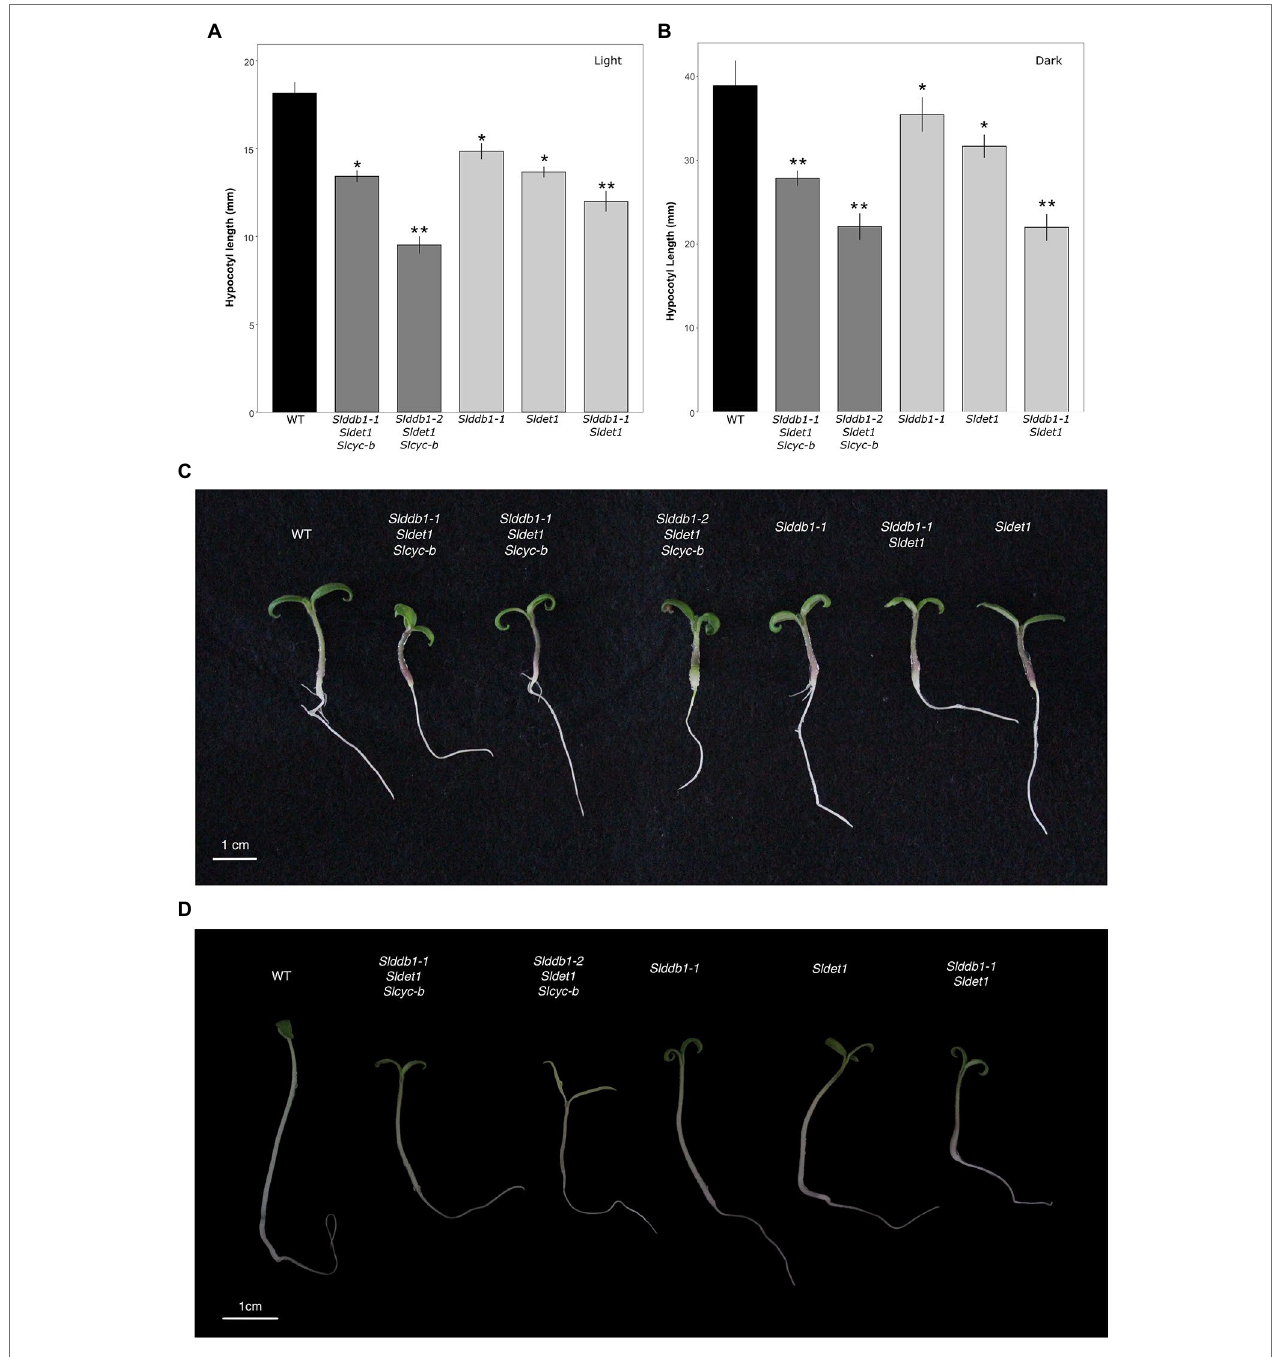
FIGURE 3 | Photomorphogenesis in segregating T 3 and BC 1 F 3 generations. Seedling development of 7-day-old germinated seeds in the T 3 and BC 1 F 3 generations under light or dark conditions, as indicated. (A,B) Hypocotyl length measurements in the T 3 and BC 1 F 3 generations under light and dark conditions, respectively. Black indicates WT, dark gray indicates T 3 triple mutant lines, and light gray indicates BC 1 F 3 segregants. (C) Photography of 1 week-old germinated plantlet under light condition. White bar indicates 1 cm. (D) Photography of 1 week-old germinated plantlet under dark condition. White bar indicates 1 cm. Error bars indicate SE, and * and ** indicate significant differences from WT and the single mutant, respectively, at 0.05 based on a t